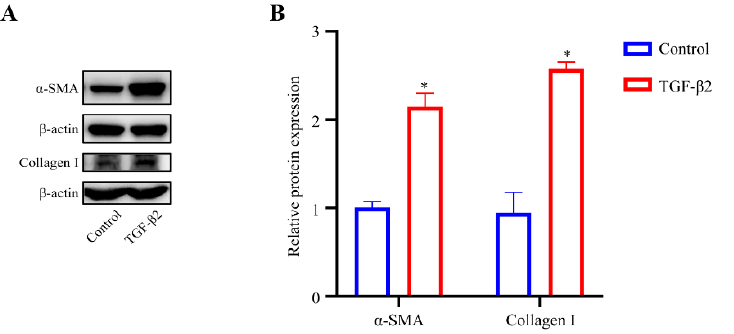
Figure 3. TGF- β2 treatment induced the fibrotic activity of HTM cells. ( A ) Serum-starved HTM cells (24 h) treated with TGF- β2 (5 ng /mL for 48 h) presented a significant increase in the levels of α -SMA and Collagen I compared with the control cells. ( B ) Quantification analyses of α -SMA and Collagen I expression levels. * p < 0.05.